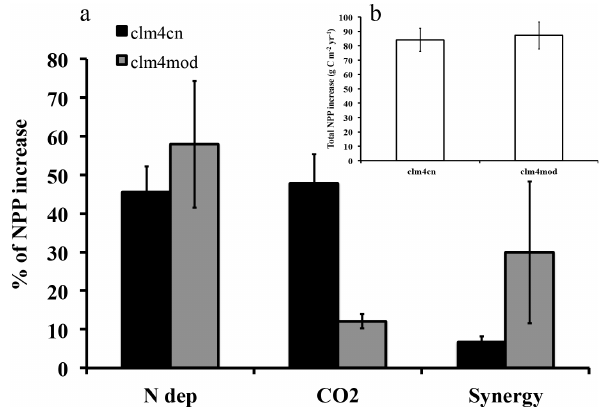
Fig. 5. Model predictions of net primary production (NPP) response to rising nitrogen deposition and atmospheric CO 2 averaged across all five sites (a) . The total NPP increase between 1850 and 2004 ( b ; in- set) is partitioned into the increase due only to nitrogen de- position, only to CO 2 fertilization, and the synergy between nitro- gen deposition and CO 2 fertilization. Error bars represent variation among sites